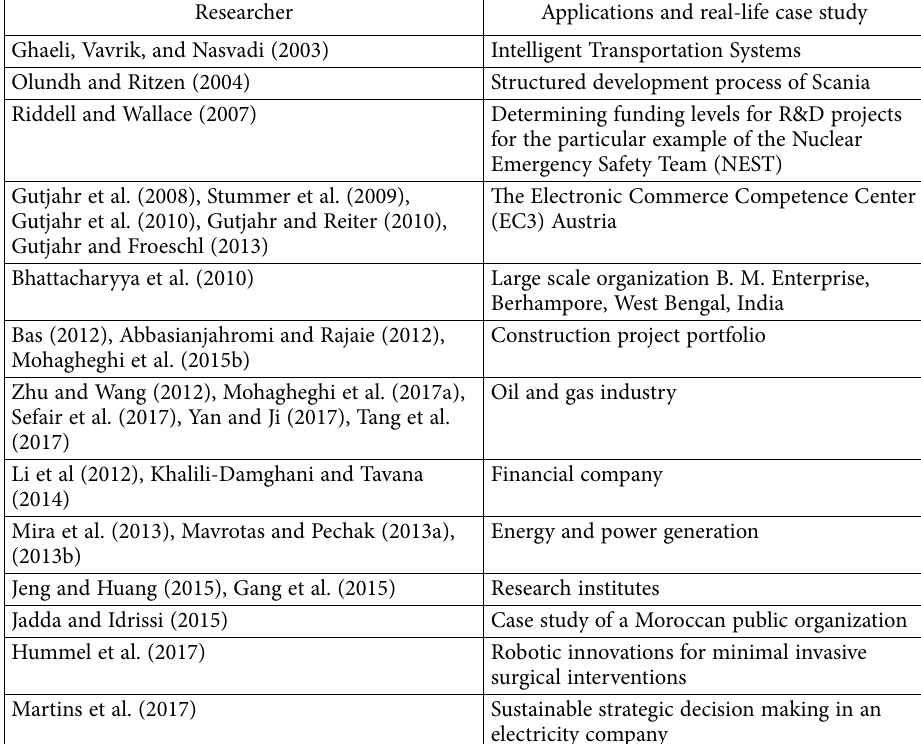
Table 16. Areas of real-life case studies of PPS